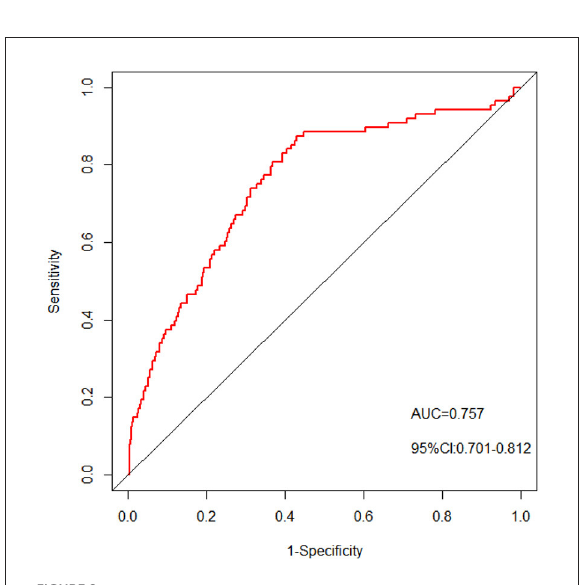
FIGURE2 The pooled AUC of the ROC curve. The y-axis means the true positive rate of the risk prediction. The x-axis means the false positive rate of the risk prediction. The red line represents the performance of the